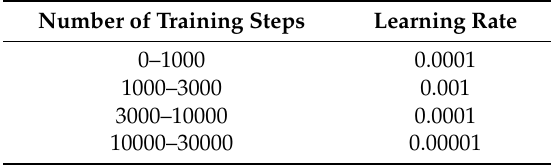
Table 3. Multi-stepping strategy for learning